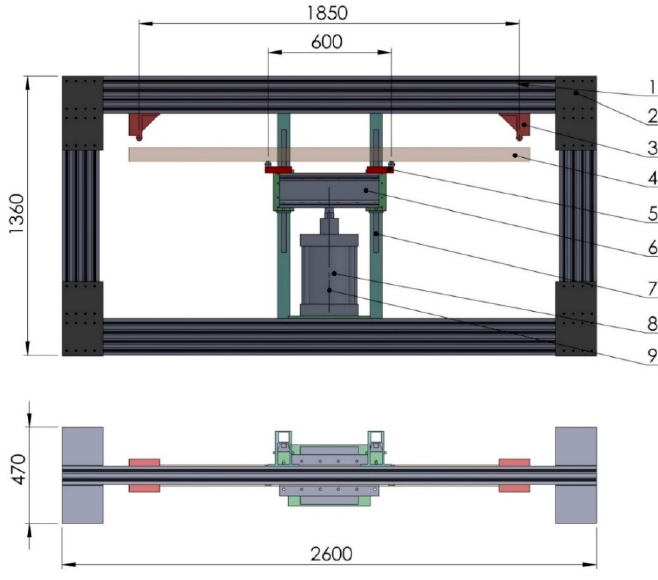
Figure 3. Components of the test rig: 1. Frame, 2. Frame connecting plate, 3. Support, 4. Specimen, 5. Load cell, 6. Pressure element, 7. Pressure element guide, 8. Pneumatic cylinder, 9. Displacement